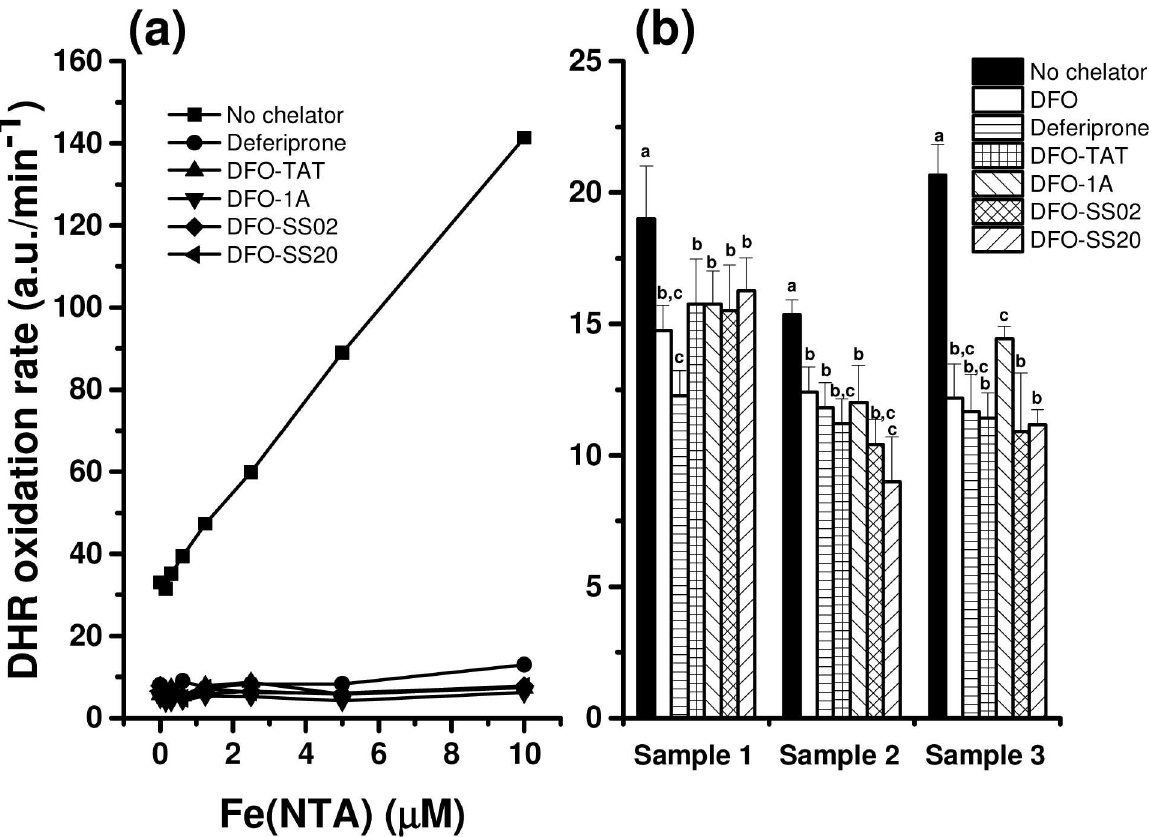
Fig 3. Antioxidant activity of mtDFO (20 μ M). Their effects on the oxidationrate of the probe DHR treated with (a) increasing amounts of Fe(NTA) or (b) serum of iron-overloaded myelodysplastic patients are displayed. For n = 4, p < 0.05. a.u. = arbitrary units of fluorescence. Results are the averageof quadruplicates and representative of at least two isolatedexperiments. Different letters indicate significantdifferences with control (no chelator) after one way ANOVA (P < 0.05).